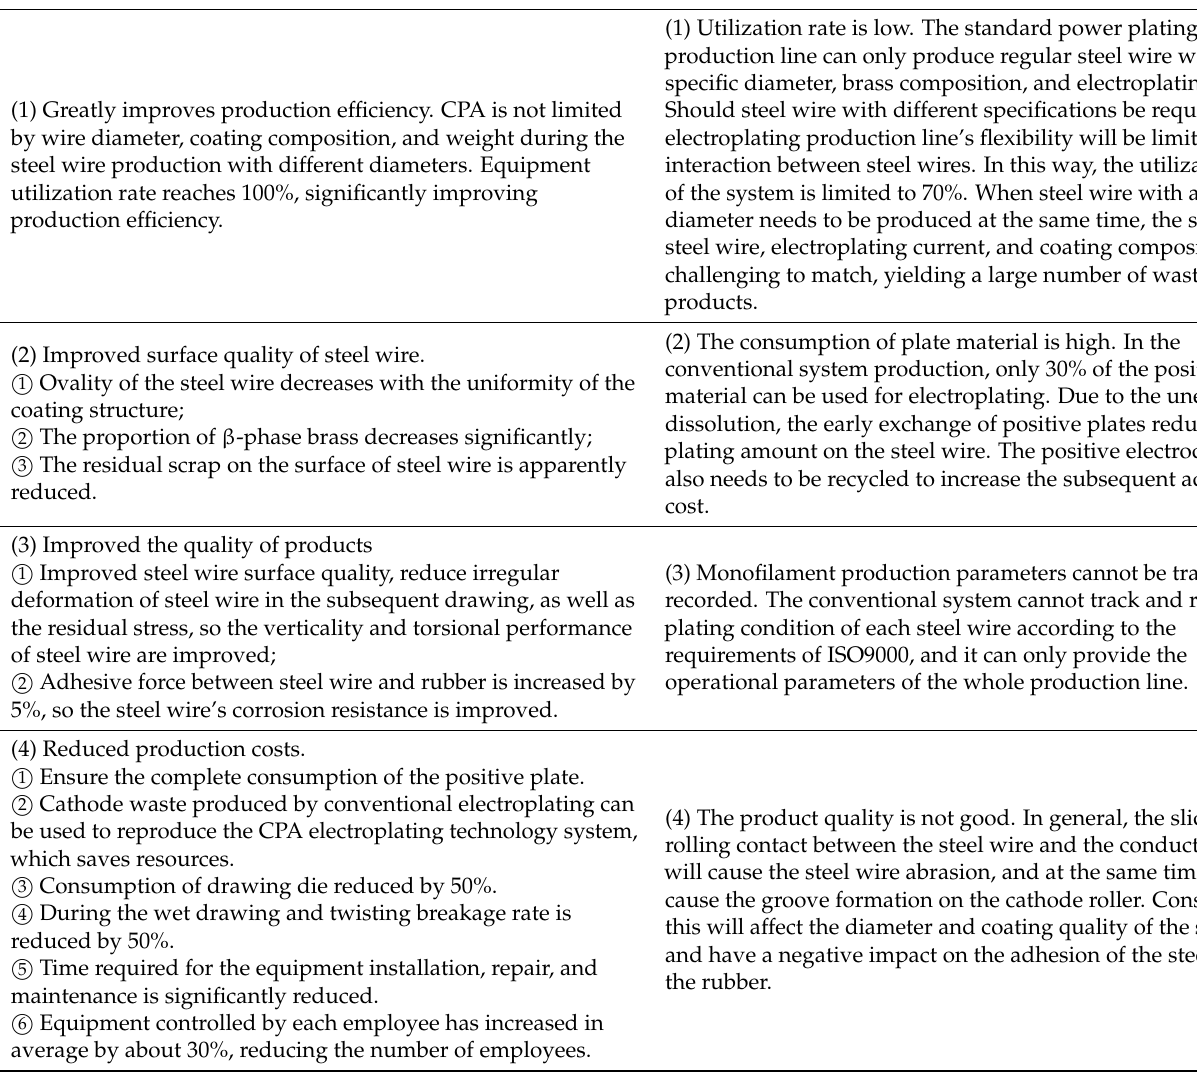
Table 4. Comparison between conventional brass plating technology and CPA electroplating technology. Advantages of CPA Electroplating Technology